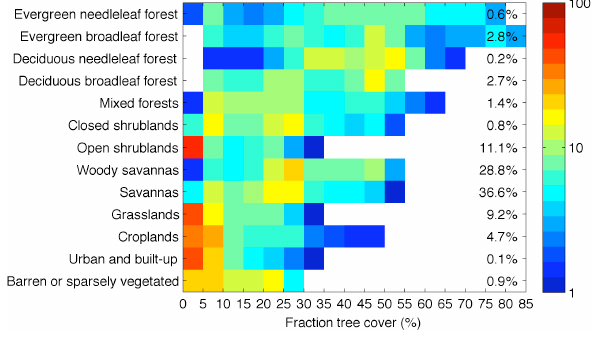
Fig. 2. Percent of burned area in each land cover class (MOD12Q1, UMD land cover classification) and fractional tree cover bin (MOD44, 5% bins). Numbers on the right denote the average contribution of each land cover type to global burned area over 2001-2009.